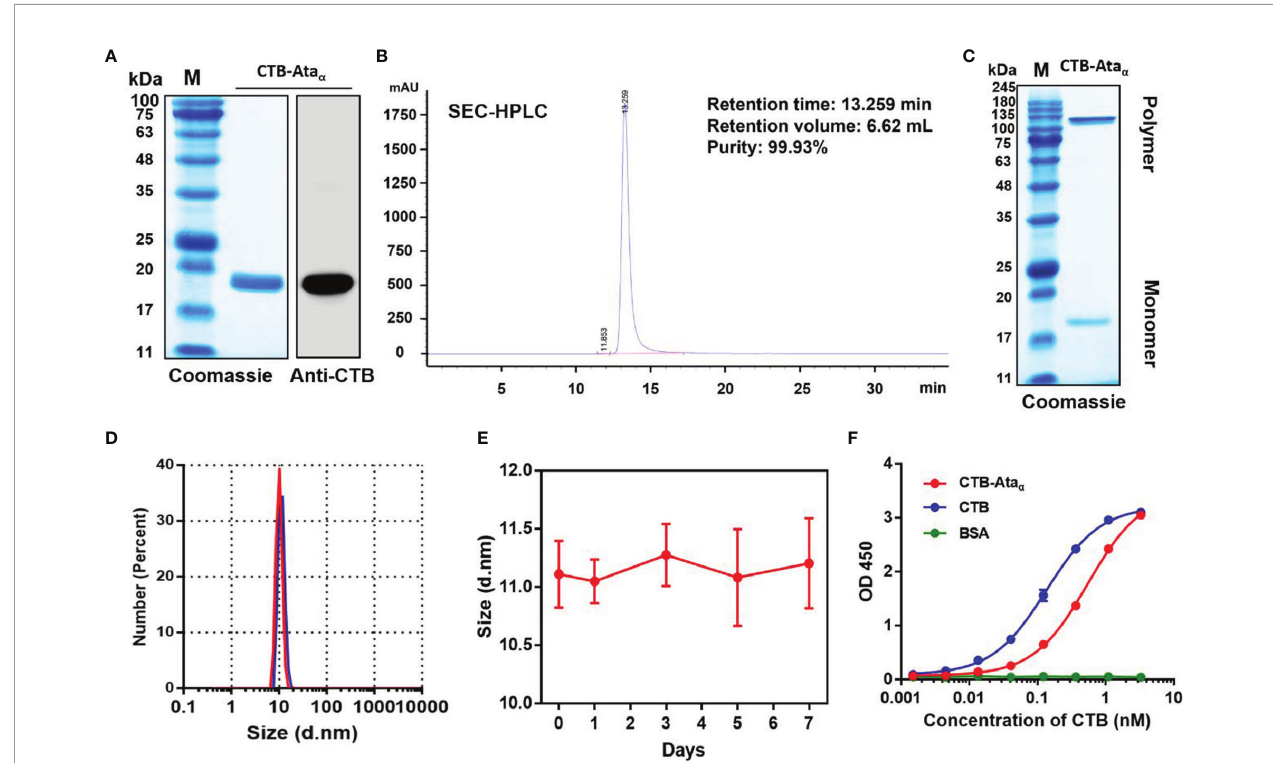
FIGURE 1 | Preparation and characterization of CTB-Ata a . (A) Identi fi cation of puri fi ed CTB-Ata a by SDS-PAGE and Western blot with anti-CTB. (B) SEC-HPLC (TSK gel G2000SWXL, 5 m m, j 7.8 × 300 mm) to determine the purity of CTB-Ata a . (C, D) Puri fi ed CTB-Ata a was analyzed by non-reducing SDS-PAGE (C) and DLS (D) . (E) DLS analysis of CTB-Ata a size stability at different time points upon incubation at 37°C. Data are presented as means ± s.d. (F) The GM1 binding assay was performed to detect the binding activity between CTB-Ata a and GM1. The plate was coated with GM1 at 2 m g/mL (100 m L/well), and commercial CTB and puri fi ed CTB-Ata a were 3-fold serially diluted from 3.3 nM. Data are presented as means ±